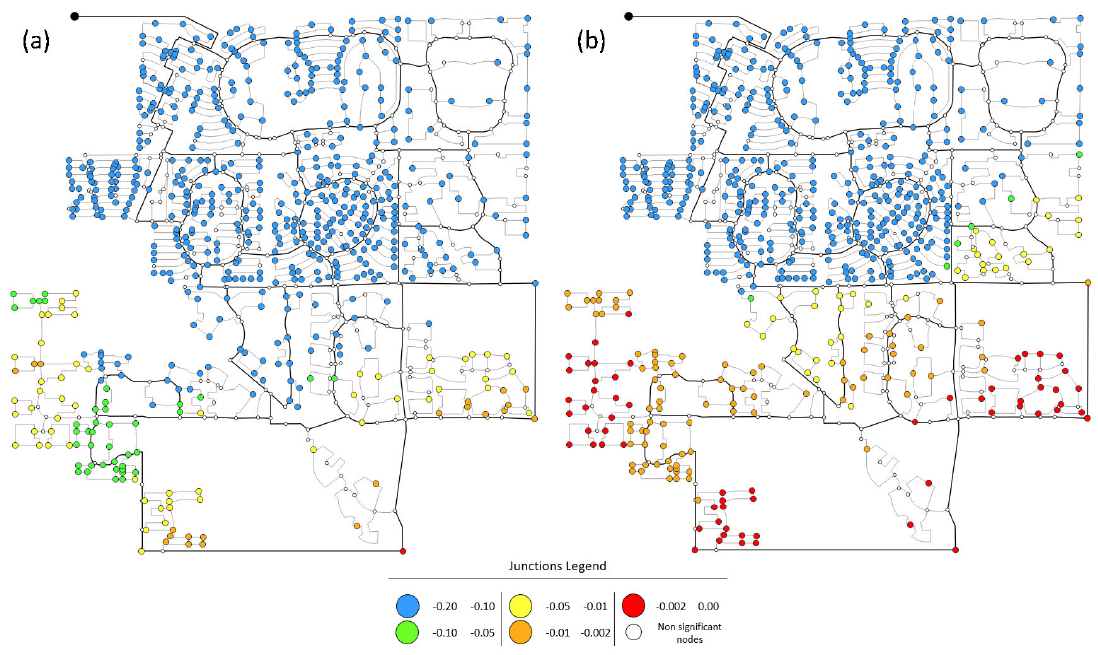
Figure 8. Comparison of the graphs containing the local discharge surplus index obtained by PDA simulation for different peak coefficients. ( a ) P c = 2.25. ( b ) P c = 2.5.